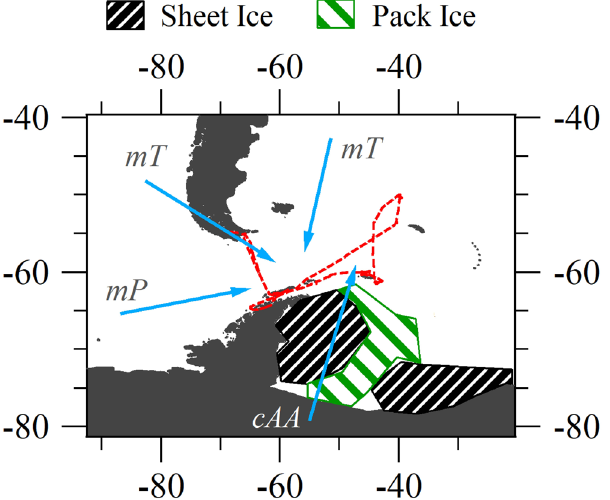
Figure 1. Map of Southern Ocean region, ship course marked in red. Movement of air masses from three principal source regions shown in blue arrows; continental Antarctic ( cAA ), maritime Polar ( mP ) from the West, and maritime tropical ( mT ) or modified- mT , both from north and northwest of − 60° latitude. Approximate summer regions of pack ice (green striped) and lasting sheet ice (black striped) in the Weddell Sea are